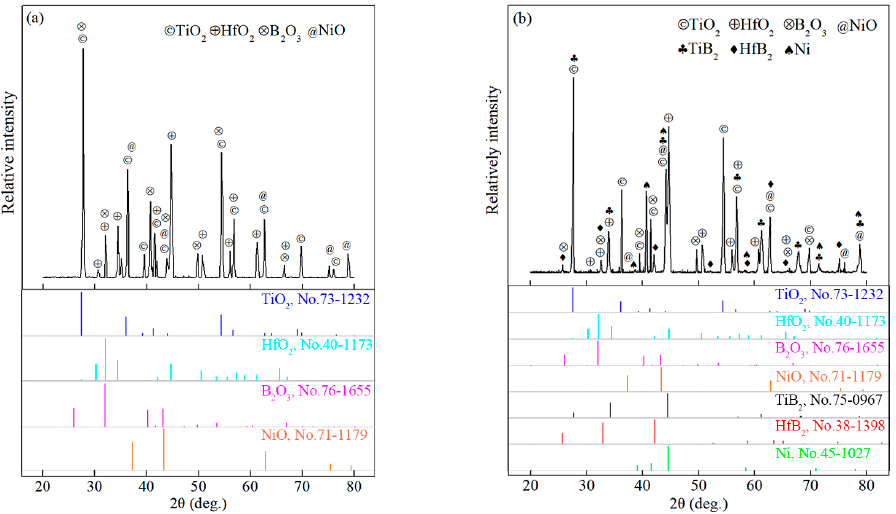
Figure 4. XRD patterns of TBHB surface and cross-section after oxidation at 1100 °C for 10 h: ( a ) surface, ( b ) cross-section.